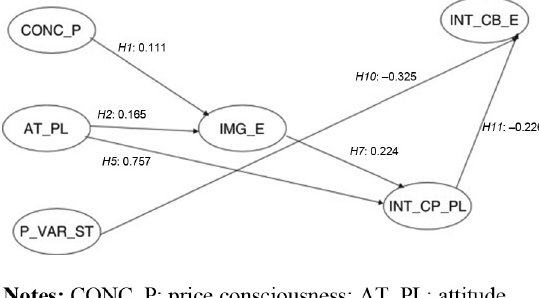
Figure 2. Final model of